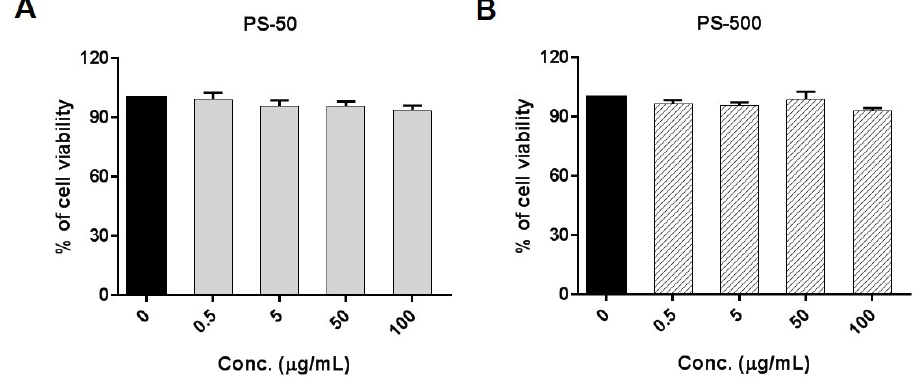
Figure 2. Polystyrene nanoplastic cytotoxicity in HNEpCs. Cell viability for PS-50 ( A ) and PS-500 ( B ) is indicated, showing the effects of increasing doses of PSNPLs for 24 h. Data are presented as the number of exposed cells relative to the nonexposed control ± SEM. Conc., concentration.